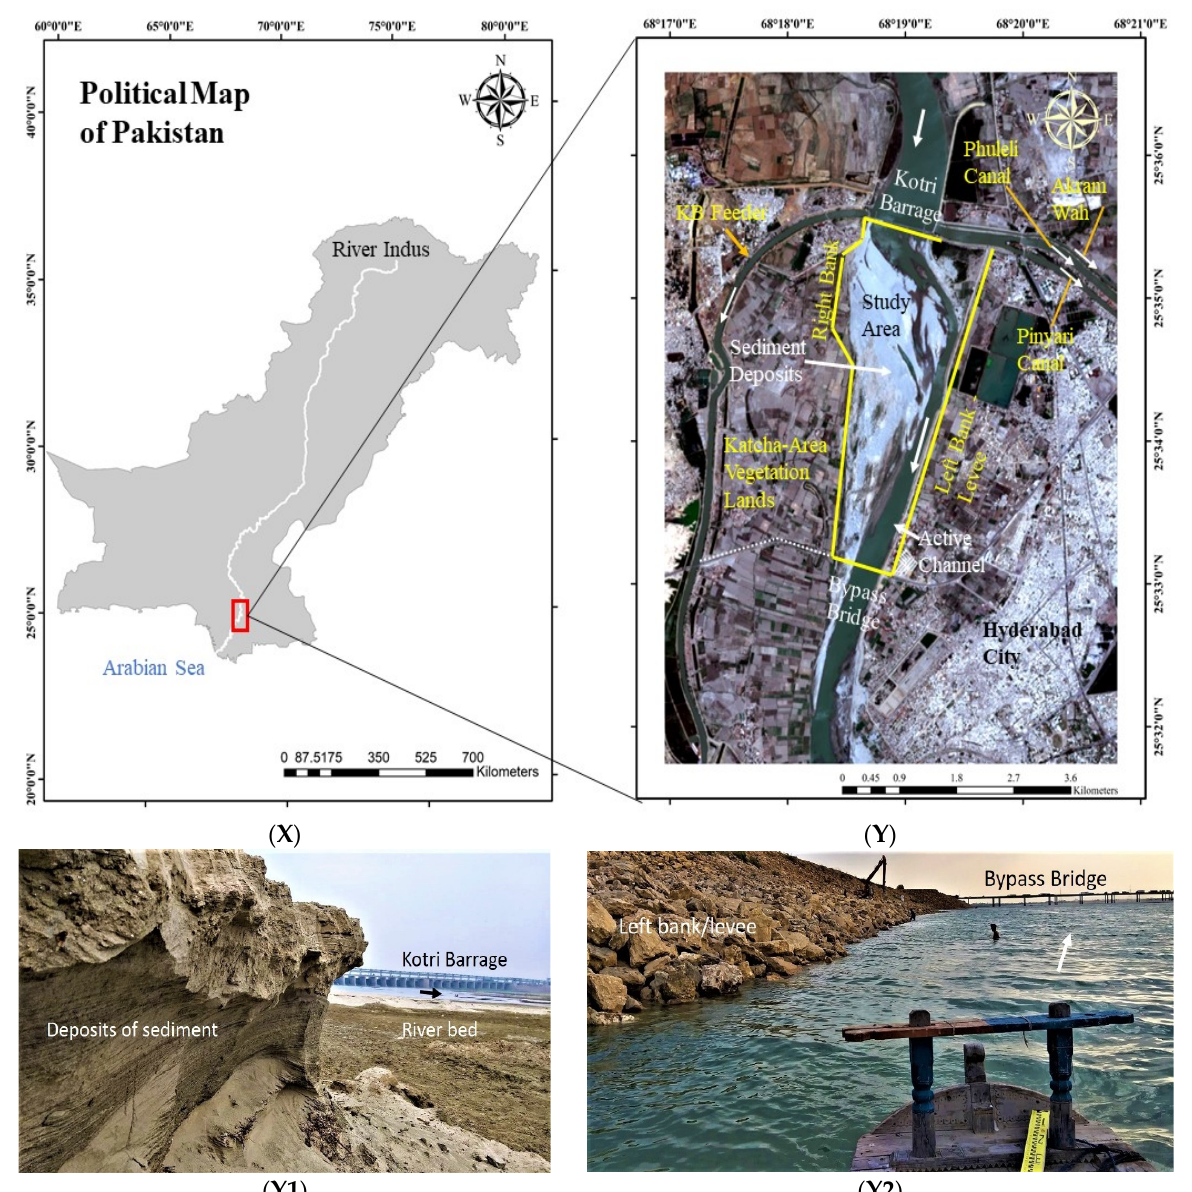
Figure 1. Image ( X ) depicts the location of study area while image ( Y ) is location map of the Indus river-reach spanning from the Kotri Barrage to the Bypass Bridge. The inset closer views of the downstream side of the barrage, i.e., images ( Y1 , Y2 ), demonstrate sedimentary deposit and branches of the active channel. River flow opts either or all channels as per sequential gates operation of the barrage.